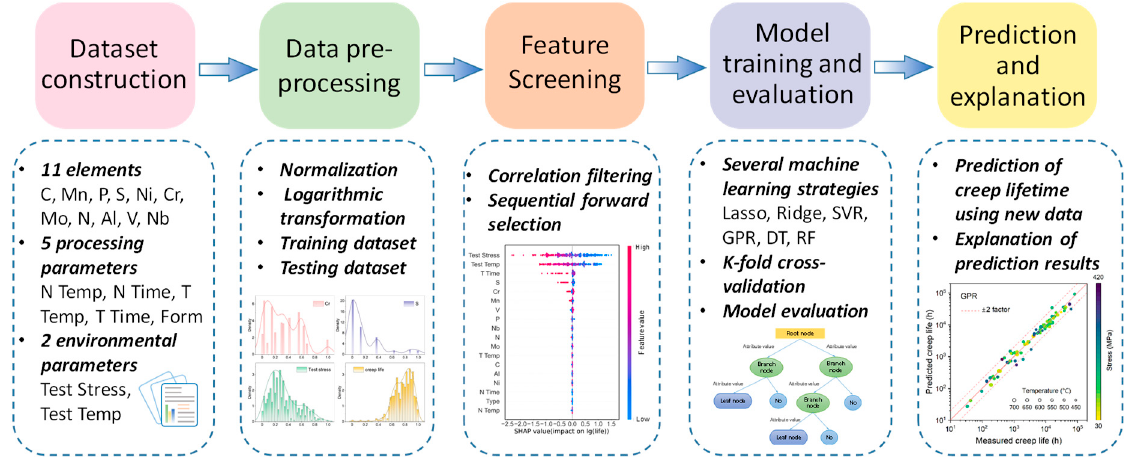
Figure 1. Machine learning-based framework for creep rupture life